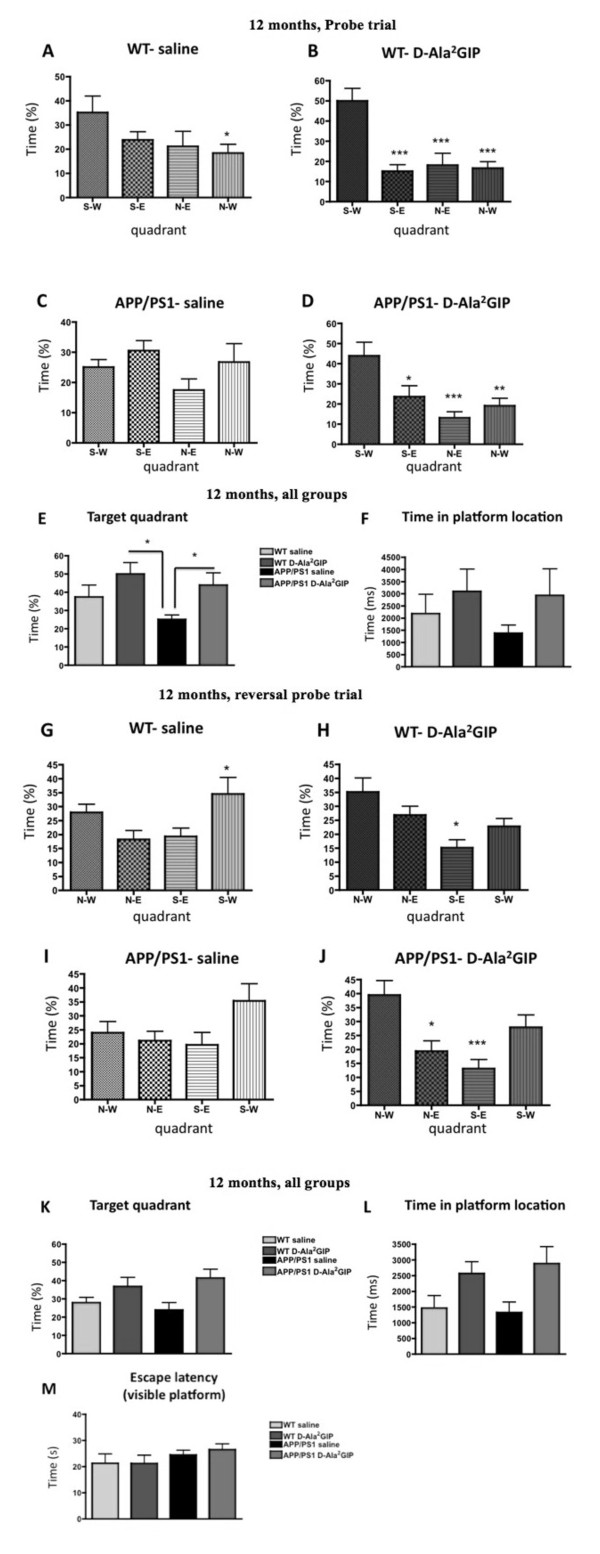
Evaluation of spatial memory during the probe trial of 12-month-old APP/PS1 mice and wild type age-matched mice injected with saline or with D-Ala2 glucose-dependent insulinotropic polypeptide (GIP) for 27 days and reversal probe trial of 12-month-old mice injected for 31 days. Time spent in each quadrant of the water maze during the probe trial for wild type (WT) mice injected with (A) saline and with (B) D-Ala2GIP and APP/PS1 mice injected with (C) saline and with (D) D-Ala2GIP. Data represent mean ± standard error of the mean (SEM) of 11 WT mice injected with saline, 12 WT mice injected with D-Ala2GIP and 11 APP/PS1 per group. (E) Time spent in the target quadrant for all groups. (F) Time spent crossing the platform previously located during acquisition task. Data represent mean ± SEM of 11 WT mice injected with saline, 12 WT mice injected with D-Ala2GIP and 11 APP/PS1 per group (one-way analysis of variance, ANOVA). At 12 months, time spent in each quadrant of the water maze during the probe trial for WT injected with (G) saline and with (H) D-Ala2GIP and APP/PS1 mice injected with (I) saline and with (J) D-Ala2GIP. Data represent mean ± SEM of 11 WT mice injected with saline, 12 WT mice injected with D-Ala2GIP and 11 APP/PS1 per group (one-way ANOVA; post hoc test, *P < 0.05; **P < 0.01; ***P < 0.001). (K) Time spent in the target quadrant for all groups. (L) Time spent crossing the platform previously located during acquisition task (one-way ANOVA, * P < 0.05). (M) Evaluation of visual acuity of 12-month-old APP/PS1 mice and WT age-matched mice injected with saline or with D-Ala2GIP, during the visible platform task. Escape latency for the four trials was average for each mouse (one-way ANOVA).